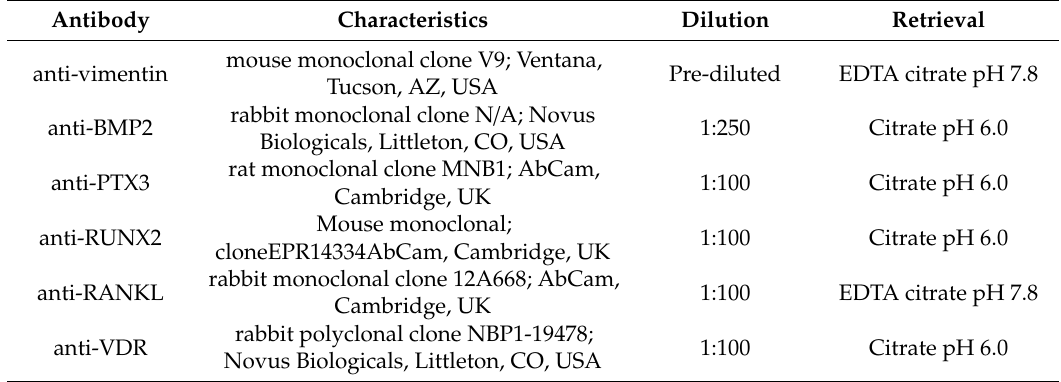
Table 1. List of primary